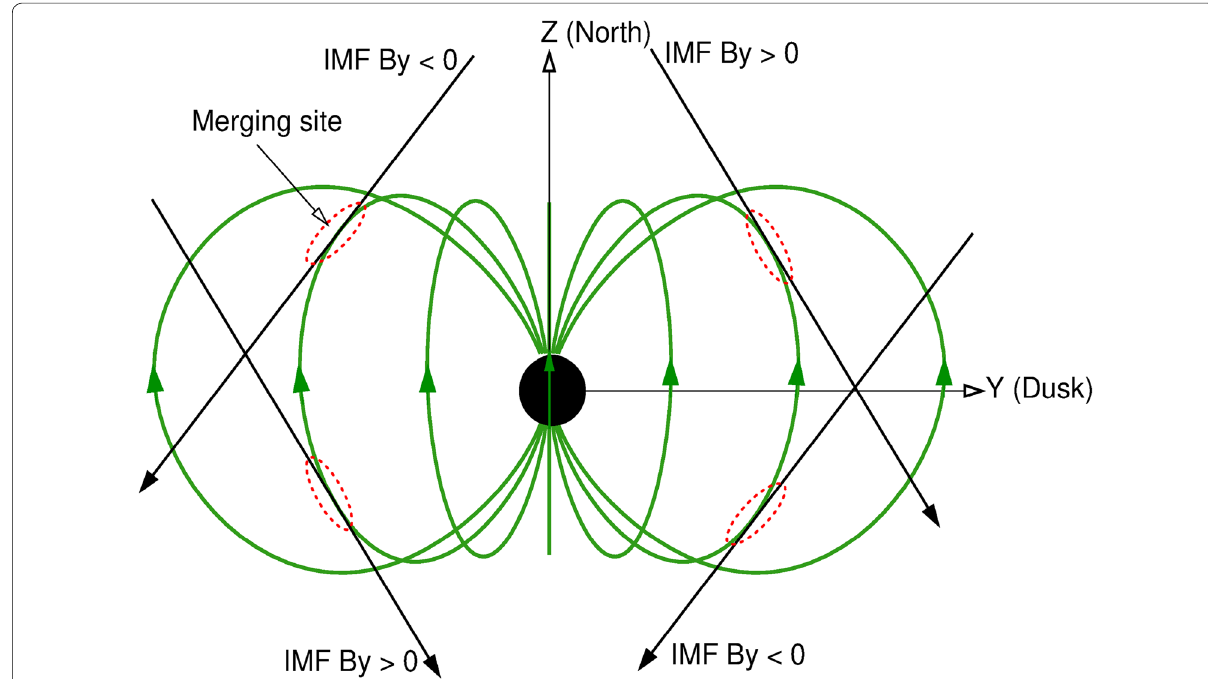
Fig. 1 Schematic drawing of magnetic field line merging between the interplanetary (black) and Earth (green) magnetic fields predicted by the anti-parallel merging model as viewed from the Sun. For a positive IMF B y component, the merging sites (red dashed ellipses) are located at the high-latitude dusk (dawn) sector of the Northern (Southern) Hemisphere. For a negative IMF B y component, the merging sites change to high-latitude dawn (dusk) sector of the Northern (Southern)